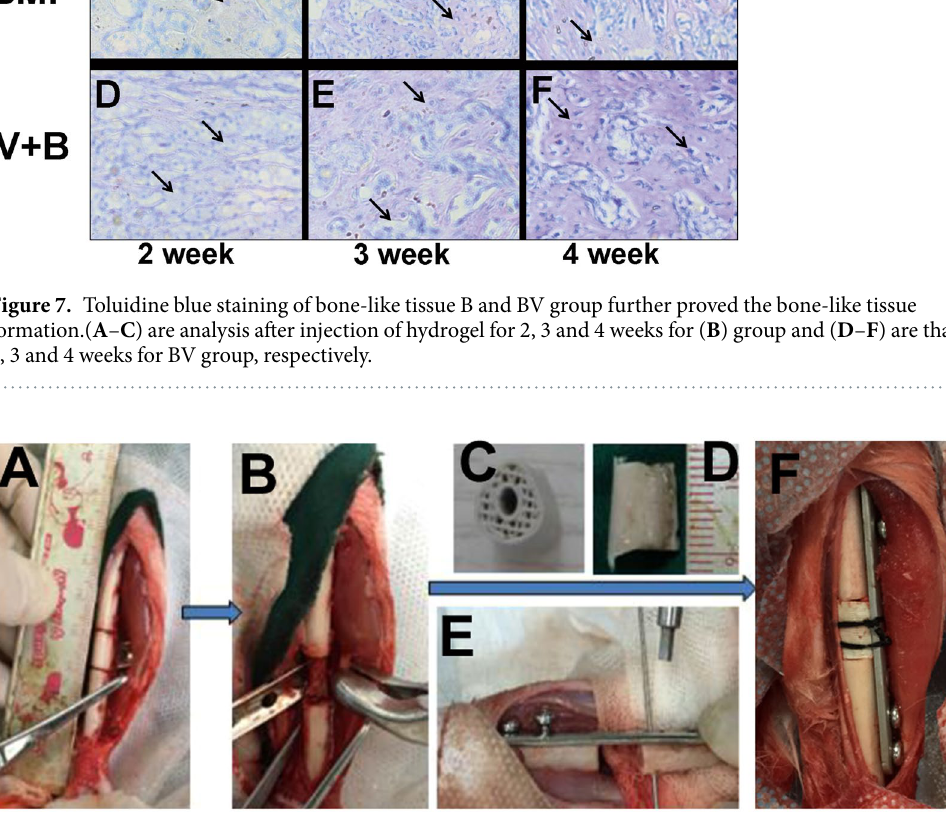
Figure 8. The operation process of aritificial bone scaffold in rabbit tibial defect. ( A ) exposure of surgical field, ( B ) construction of bone defect (1.2 cm), ( C )anatomical biomimetic artificial bone scaffold, ( D ) osteotomy of autogenous bone, ( E ) fixation of miniplate and screw fixation system, ( F ) successful bone graft transplant into bone